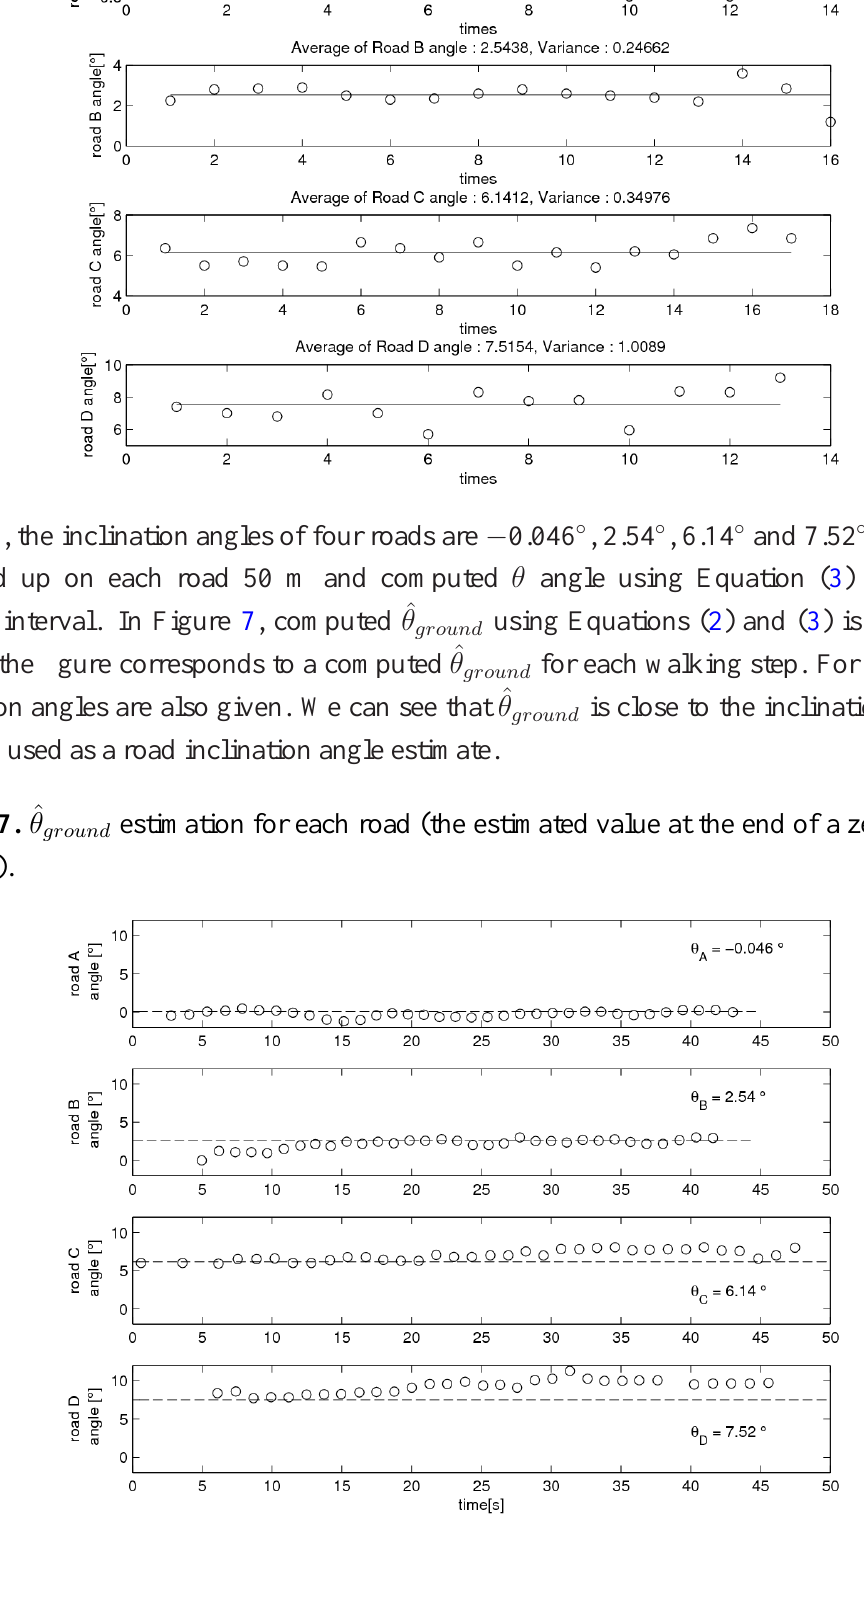
Figure 6. Inclination angle measurement with a digital inclinometer (each measurement is taken from different points along the roads).